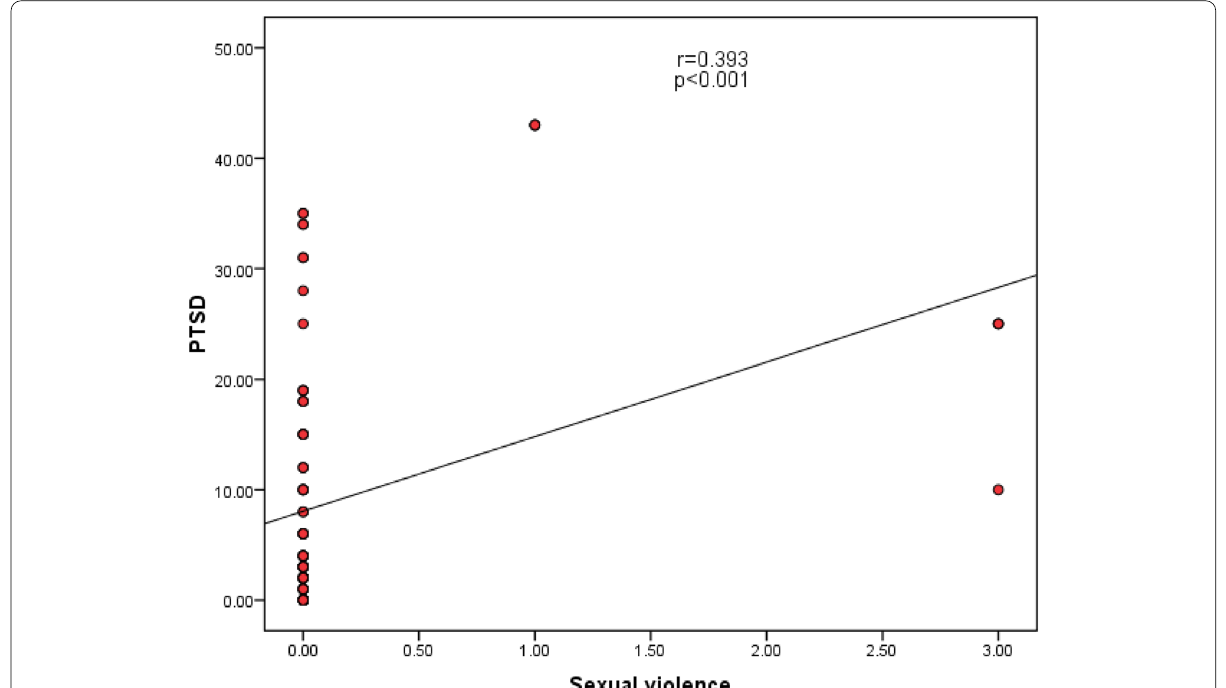
Fig. 1 Scatter diagram showing a correlation between sexual violence and post-traumatic stress disorder